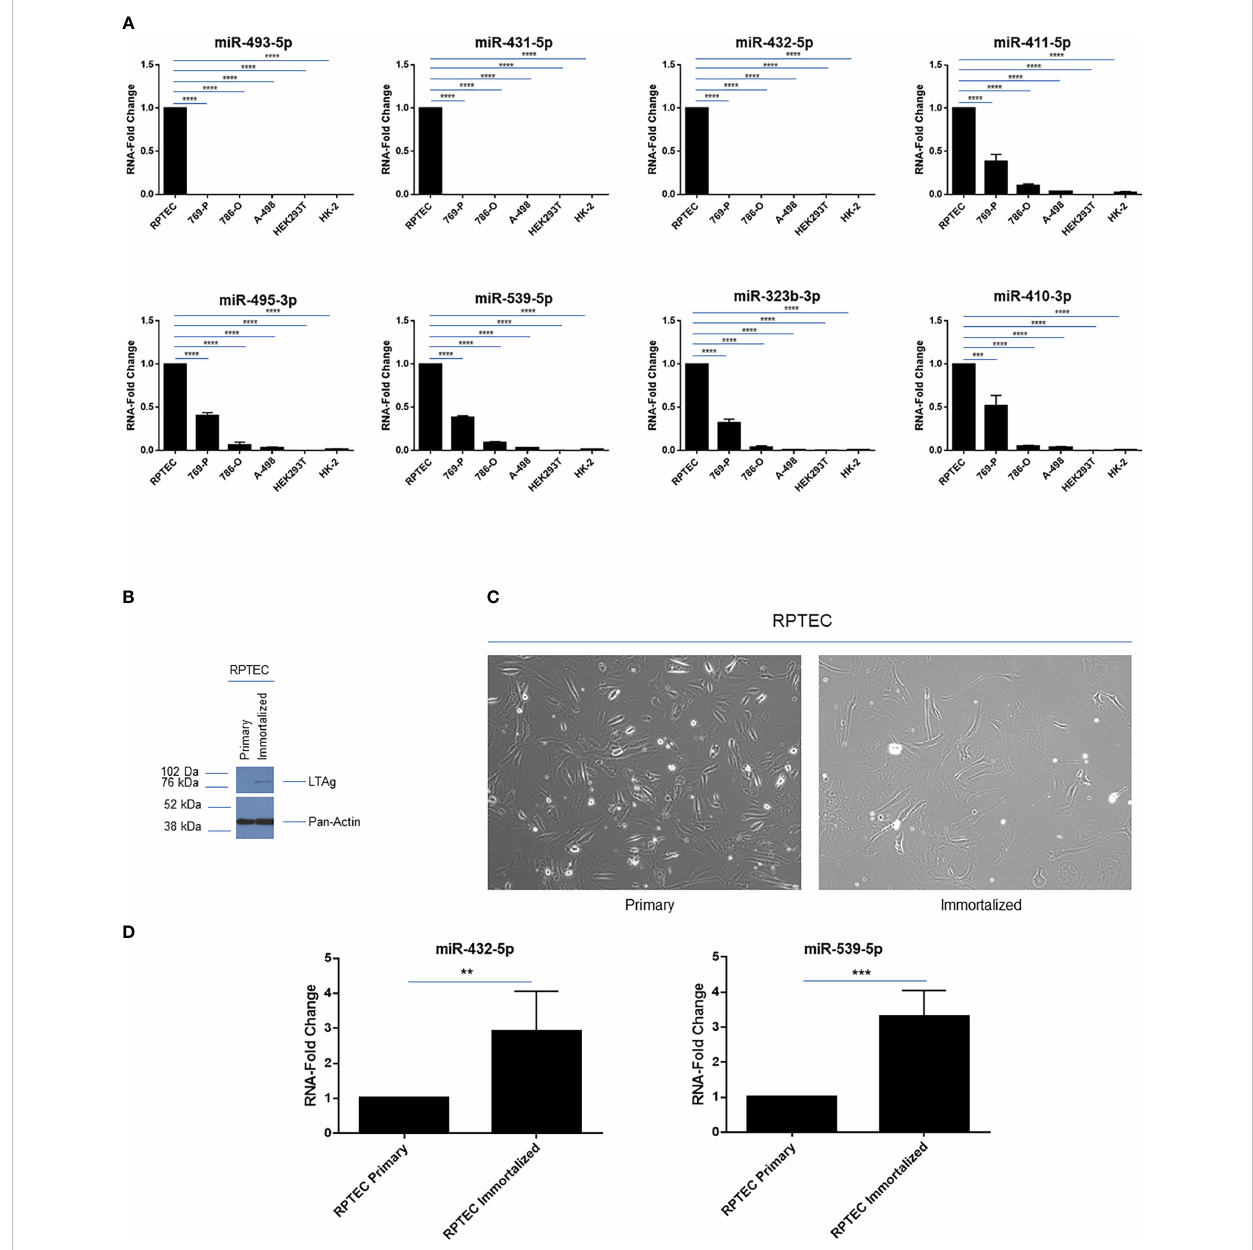
FIGURE 3 14q32 miRNA expression across a series of renal cell lines. (A) qPCR analysis of selected 14q32 miRNAs across 6 renal cell lines. miRNA-fold change values are displayed for two independent replicates (each measured in triplicate) using RNU48 as a reference control. (B) Protein lysates were obtained from primary and immortalized RPTEC cells followed by western blotting using the antibodies shown. (C) Representative images of primary and immortalized RPTEC cells are shown which were captured at 20x magni fi cation. (D) qPCR analyses of miR-432-5p and miR-539-5p in primary and immortalized RPTEC cells. miRNA-fold change values are displayed using RNU48 as a reference control. ** p -values ≤ 0.01; *** p -values ≤ 0.001; **** p -values ≤